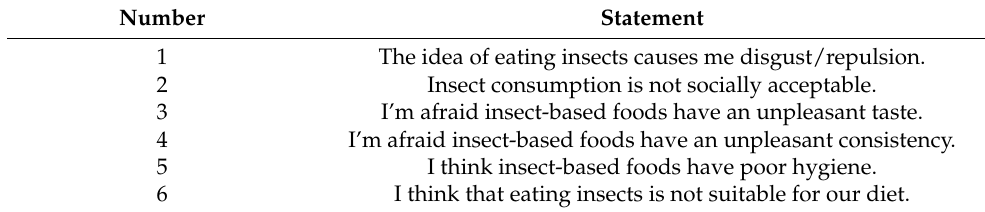
Table 3. Insect Phobia Scale